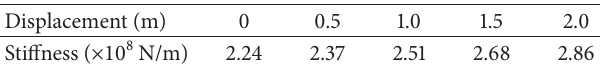
Figure 16: Effect of variations in thrust bearing stiffness on force transmissibility. Table 4: Resultant Stiffness of shafting between thrust bearing and